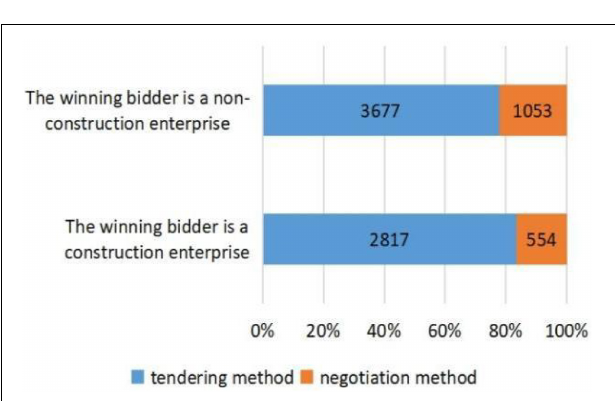
FIGURE 5 | Distribution of procurement model selection under different types of winning bidders.